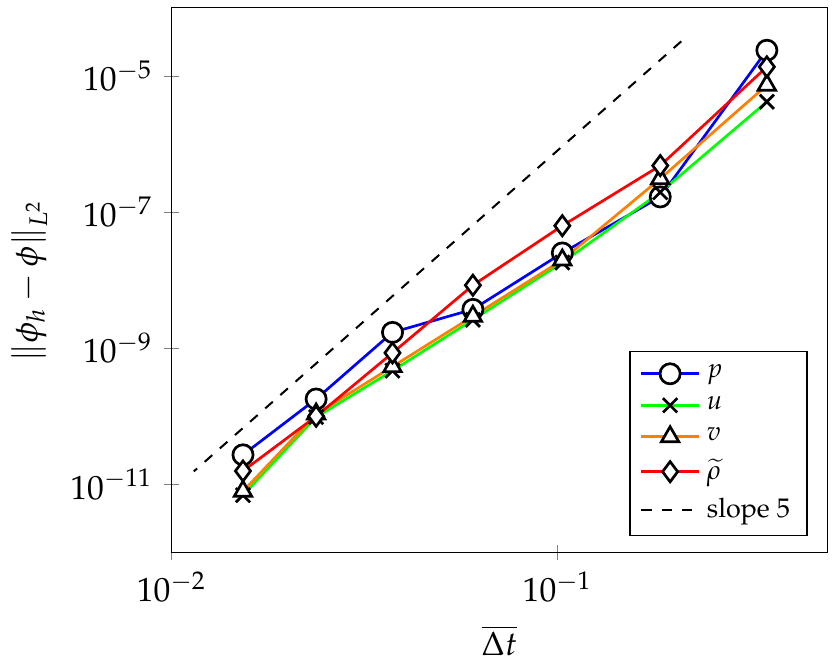
Figure 2. Guermond–Quartapelle manufactured solution—temporal convergence analysis for each variable using the implicit ESDIRK5(8) scheme and the time step